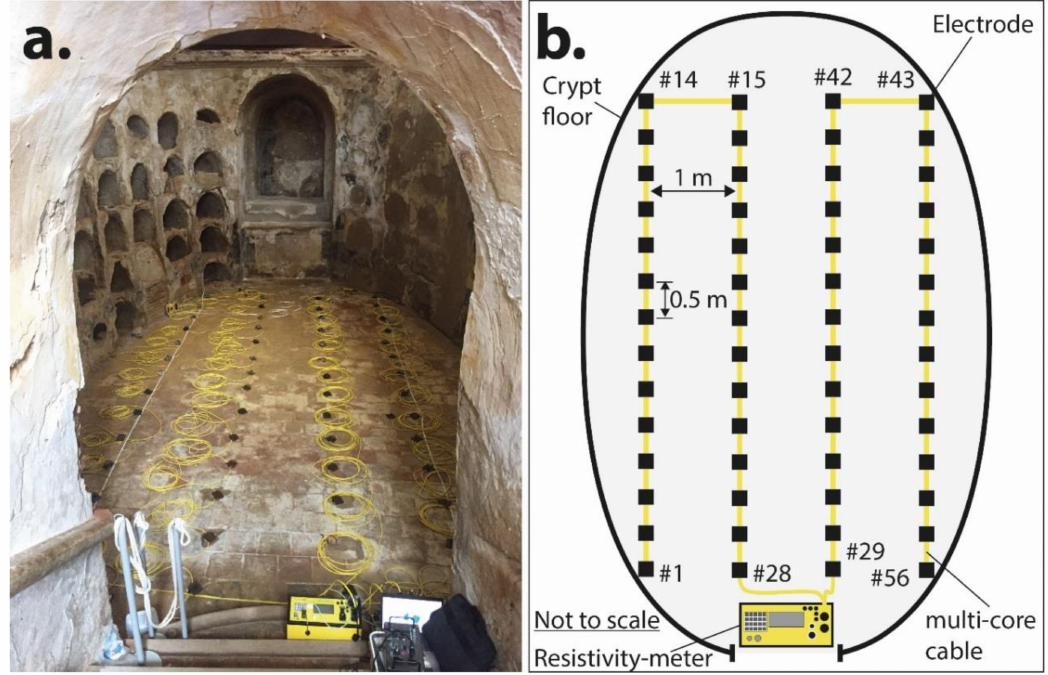
Figure 3. ( a ) Three-dimensional ERT layout on the Saint Joseph Crypt floor, and ( b ) sketch of the passive electrode and cable